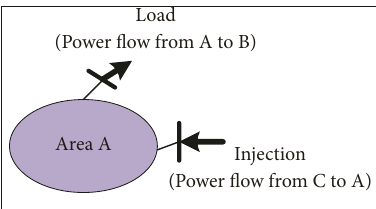
Figure 2: Representation of tie-line flows as load or injection.